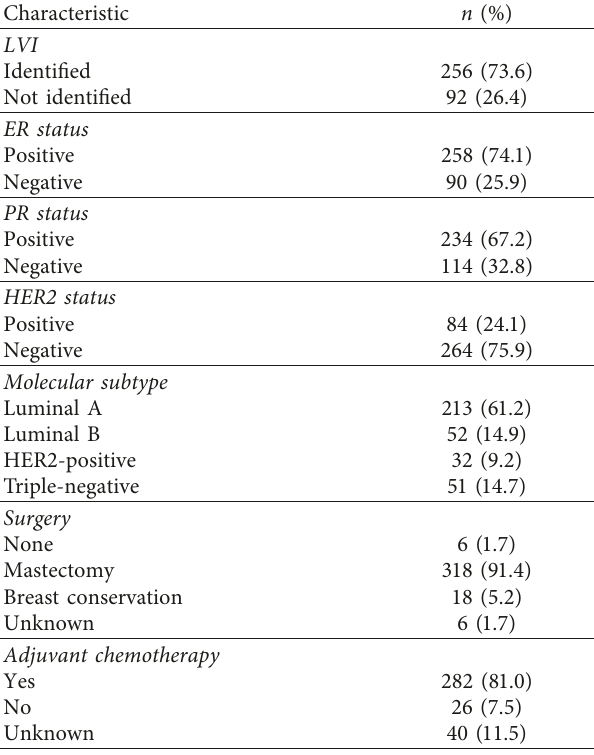
Table 2: Demographic and clinical characteristics of breast cancer patients ( N �